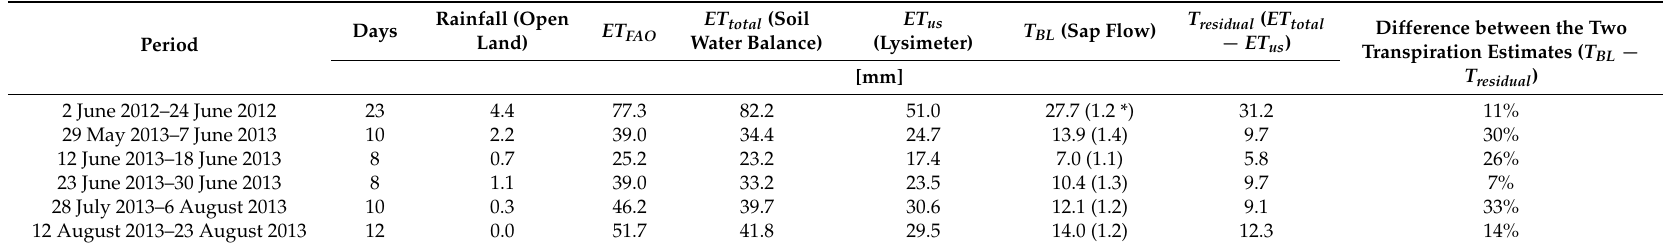
Table 3. Water balance components of a black locust stand with understory determined in periods with little or no rainfall. ET total was determined using the zero-flux-plane method (soil water balance, Equation (1)), ET us was measured using a weighable lysimeter (Equation (2)), T BL was determined using the heat dissipation method (Equations (3) and (4)), and T residual was calculated from the difference between ET total and ET us . ET FAO = grass reference evapotranspiration, ET = evapotranspiration, T = transpiration, US = understory, BL = black locust.